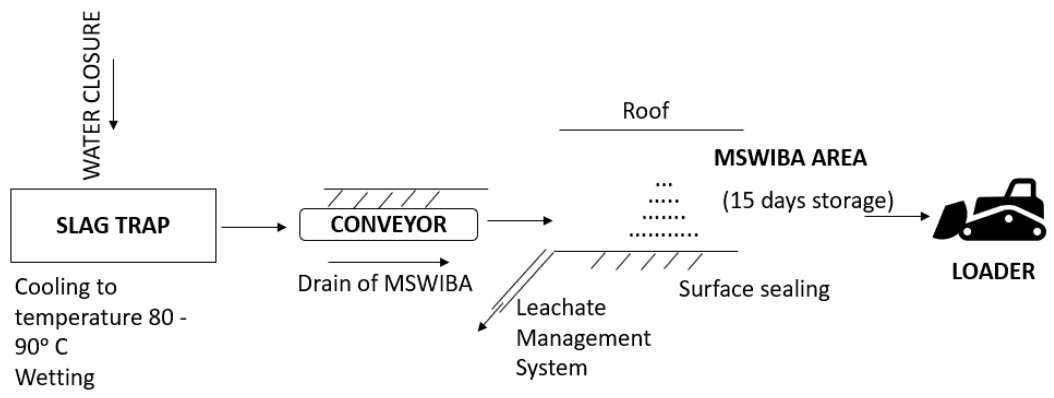
Figure 3. Municipal solid waste incineration bottom ash (MSWIBA) valorization plant [13].